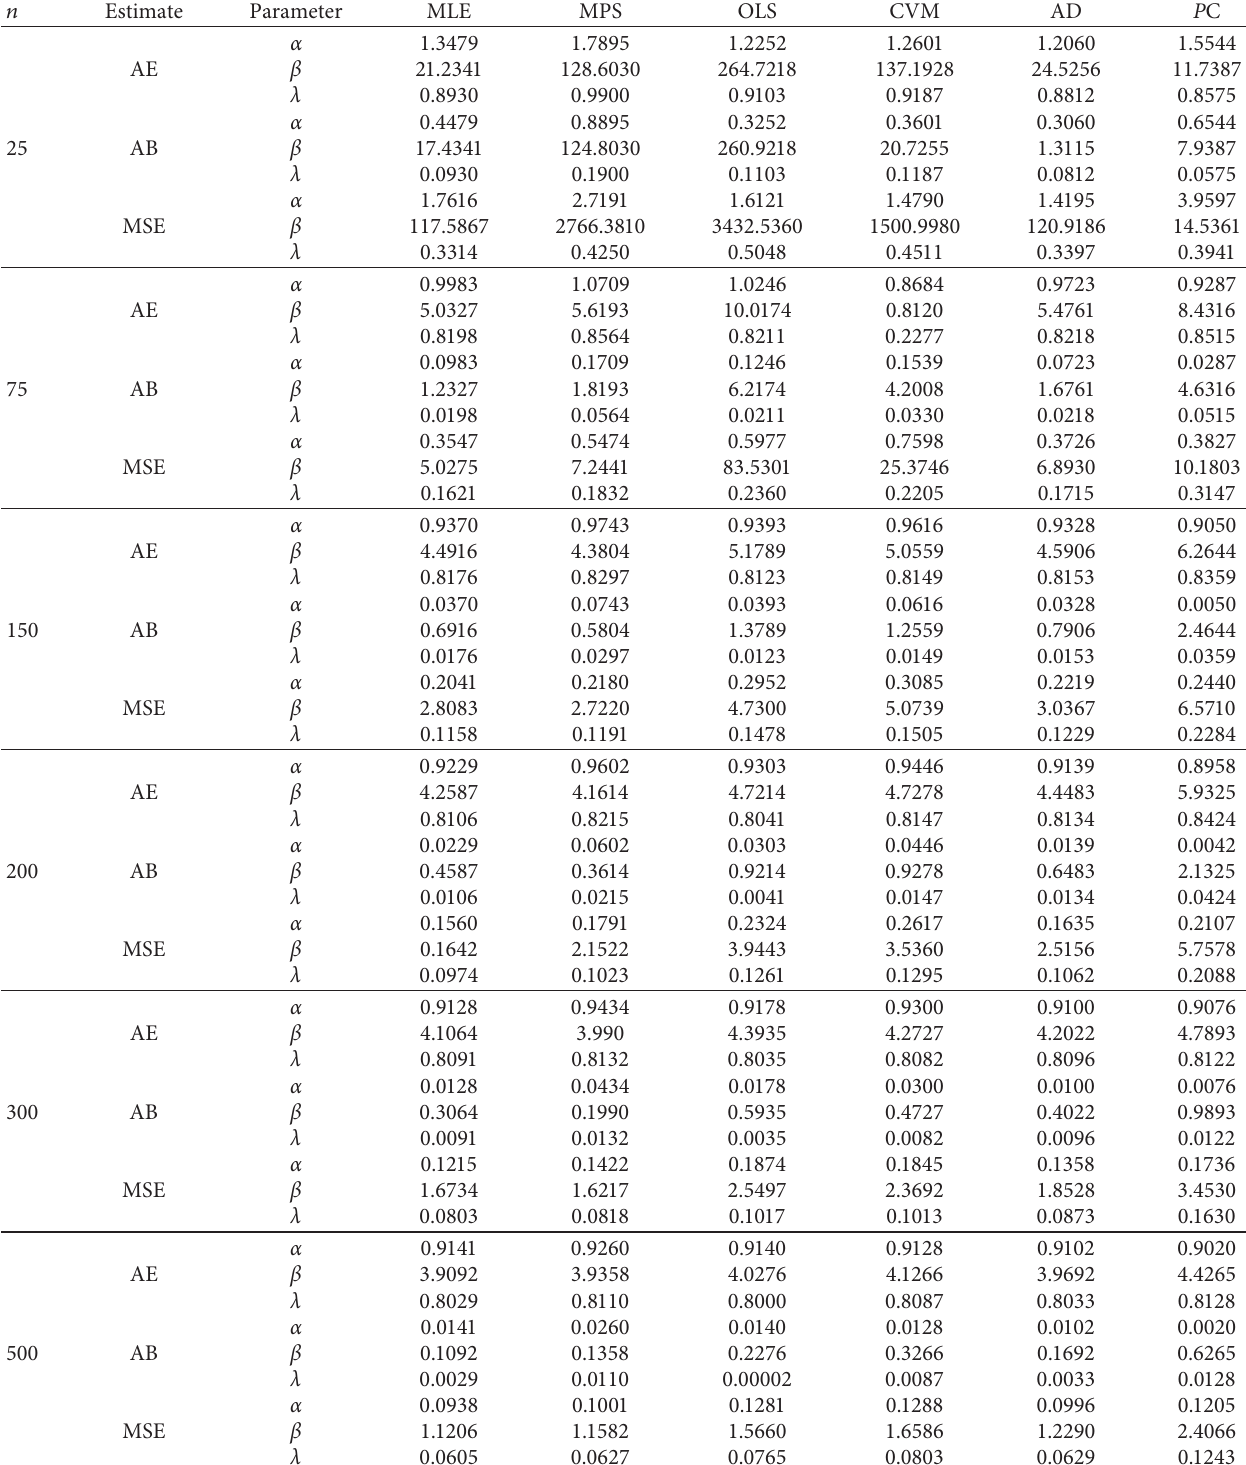
Table 3: Simulation results for α � 0 . 9 , β � 3 . 8, and λ � 0 .